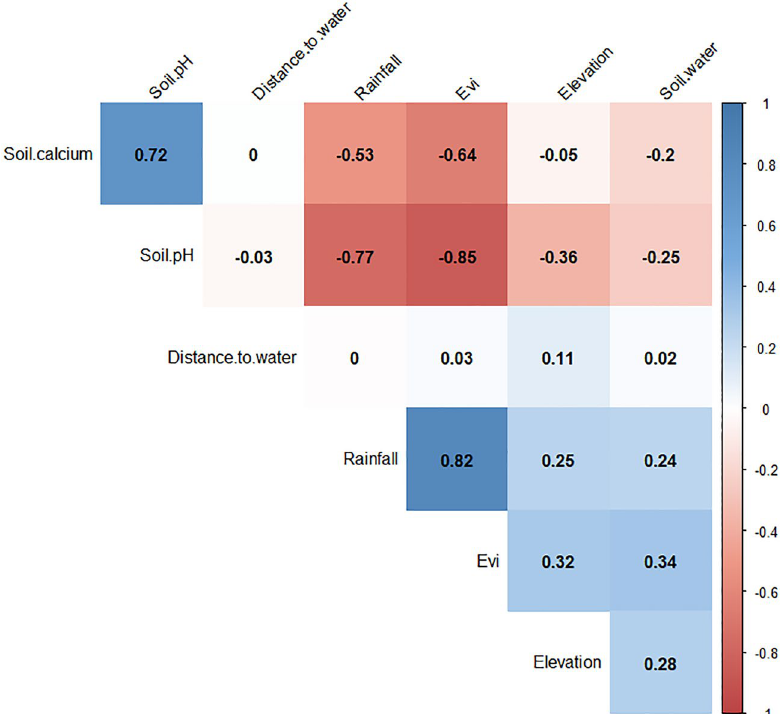
Figure 1. Results of correlation between covariates using Pearson’s correlation coefficient test for the spatial model. Correlation between covariates is shown by red numbers (negative correlation) and blue numbers (positive correlation). Correlations with a p-value > 0.01 are regarded as insignificant and the correlation coefficient values are left blank. The figure was generated using R software v. 4.1.0 28